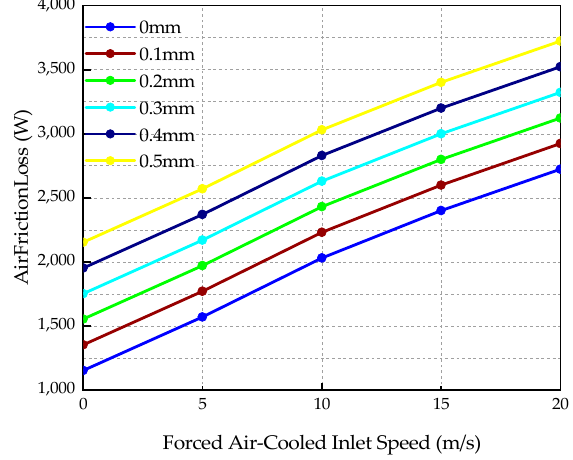
Figure 18. Air friction loss at 36,000 r/min of motor with different forced air-cooling inlet speeds for roundness errors of 0 mm to 0.5 mm.